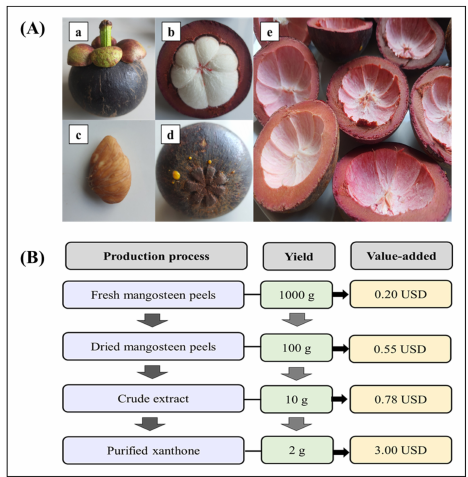
Figure 1. Mangosteen fruit and its parts (( a ) fruit, ( b ) pulp, ( c ) seed, ( d ) sepals under the mangosteen, and ( e ) peel) ( A ), and the value added from mangosteen pericarps to xanthones extract ( B